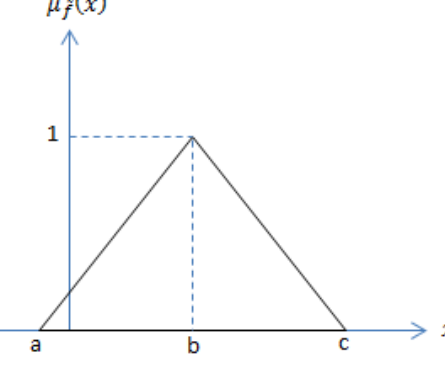
Figure 2. Triangular fuzzy number (cid:101) f = ( a , b , c )